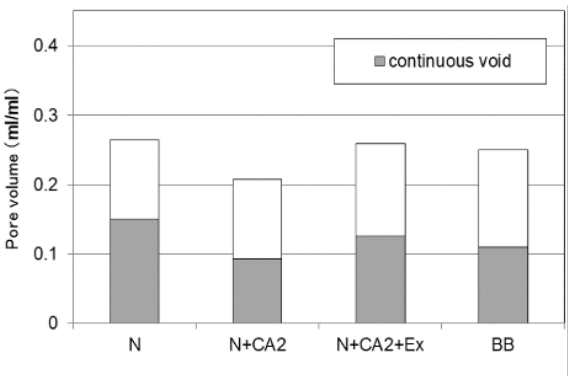
Figure 9. Pore volumes of the four samples.